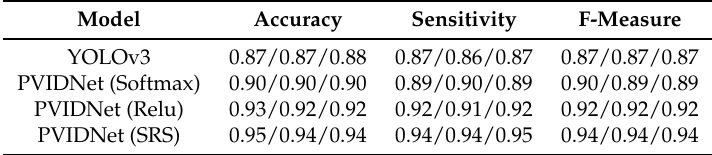
Table 11. Results of the DL algorithms to classify the images of fire trucks (right/left/front) in the testing